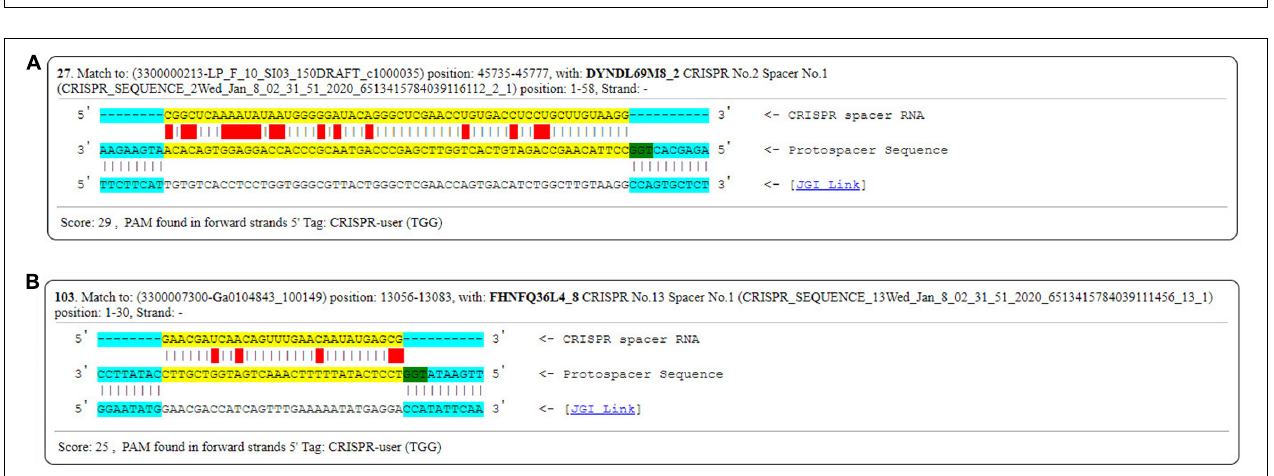
FIGURE 14 | CRISPR spacers targeting prophages in P. pentosaceus genomes. The heatmap represents P. pentosaceus CRISPR spacers that matched prophages in P. pentosaceus . The vertical axis represents the genomes that harbor prophages targeted by P. pentosaceus CRISPR spacers. The horizontal axis represents P. pentosaceus strains carrying CRISPR spacers that target prophages. The color scales represent the number of targeting events with gray squares represents the absent of matches and red squares representing the highest number of targeting.